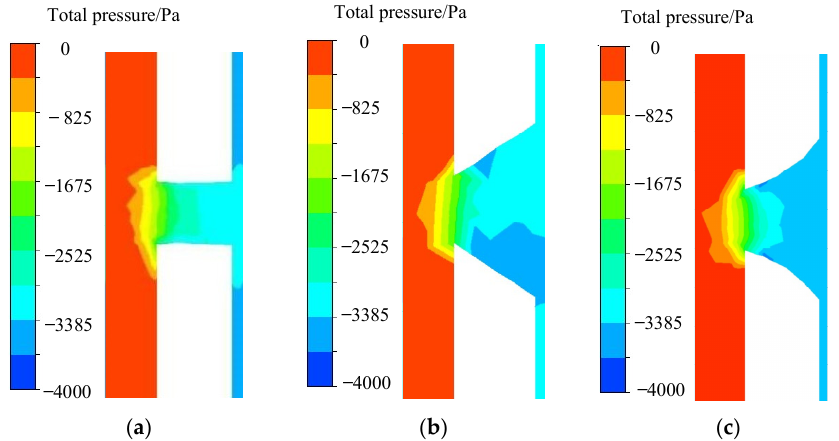
Figure 11. Air pressure contours of different structures of the seed disk holes. ( a ) Cylindrical; ( b ) conical; ( c ) arc.